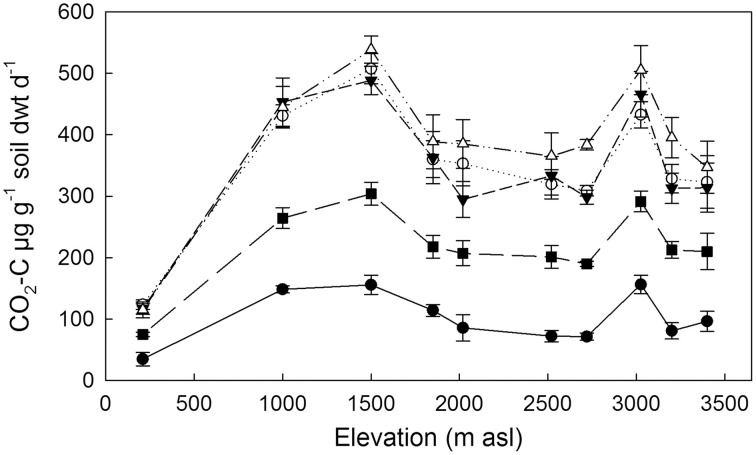
Basal and substrate-induced respiration of 10 tropical forest soils incubated at standard temperature (20°C) and moisture (75% max. WHC). Data represent mean ± SE (n = 5). Control (•), xylose (◦), vanillin (∆), hemicellulose (■), glycine (▼).